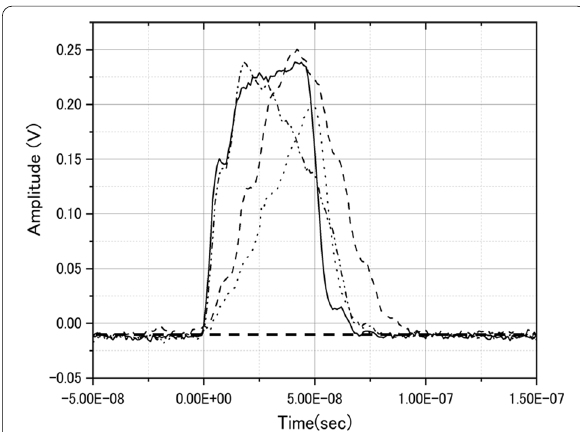
Fig. 4 Examples of four types of input laser pulses in the LIDAR-EM experiment. Solid, dashed, dotted, and dash–dotted lines indicate rectangular, gaussian, ascending triangular, and descending triangular pulses, respectively. Widths and peak amplitudes are 60 ns and 120, 40 ns and 120, 70 ns and 150, and 70 ns and 150, respectively. The horizontal thick dashed line indicates the noise floor